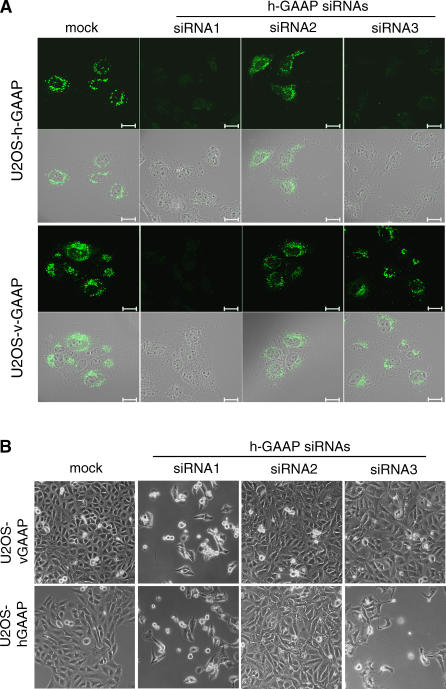
v-GAAP Complements for Loss of h-GAAP(A) U2OS-v-GAAP or U2OS-h-GAAP cells were transfected with siRNA oligonucleotides directed against h-GAAP (siRNAs 1–3) or v-GAAP (siRNA1) for 36 h. v-GAAP and h-GAAP expression was assessed by immunofluorescence using an α-HA mAb, followed by secondary Ab conjugated to FITC. The upper and third rows of panels show the fluorescent images, and the second and bottom rows show merged images of the fluorescent panel (immediately above) and an image of the same cells taken by differential interference contrast microscopy. Images shown are representative for at least three independent experiments. Scale bars, 20 μm.(B) Cell morphology of U2OS-h-GAAP or U2OS-v-GAAP cells 56 h after transfection with GAAP siRNAs 1–3 was assessed as for Figure 4B.